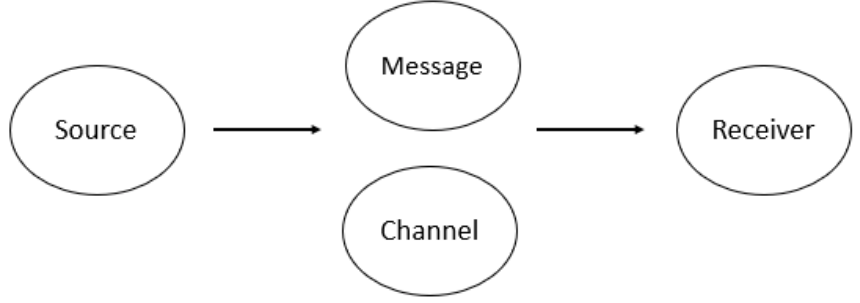
Figure 1. Berlo’s (1960) SMCR model, adapted from Kuznar and Yager (2020).